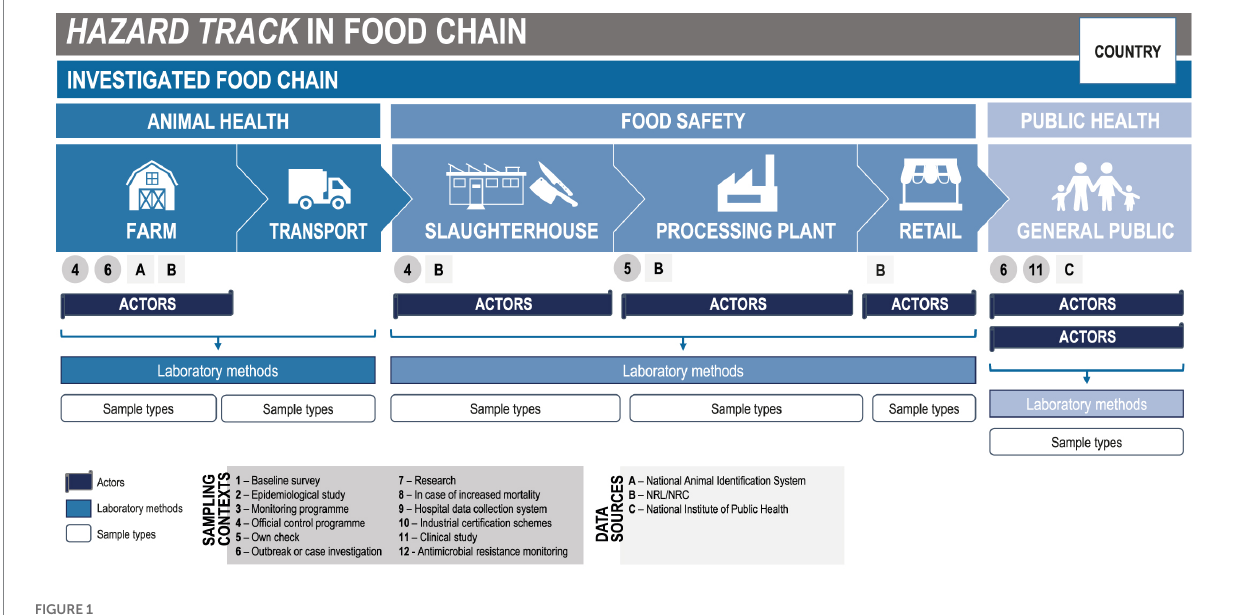
FIGURE 1 Mapping template. Modified with permission from Cito et al., 2022